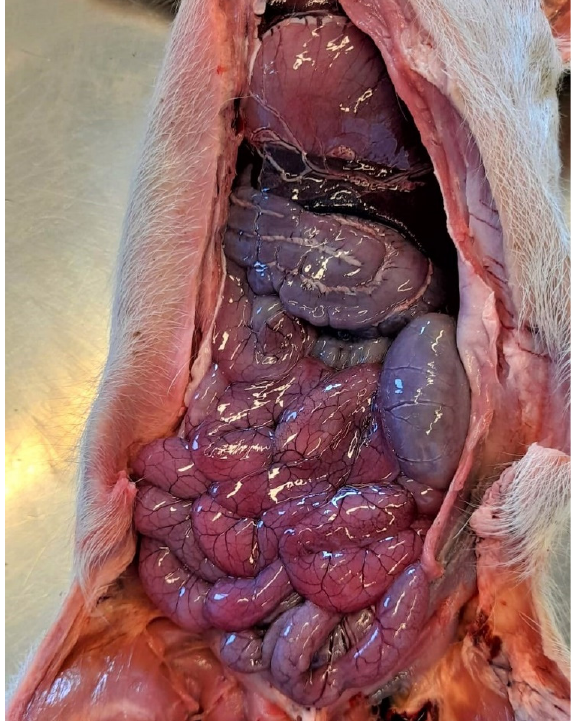
Figure 8. Pig 45 days old with colibacillosis due to F4, STa, STb. The intestine is dilated and hyper ‐ aemic.